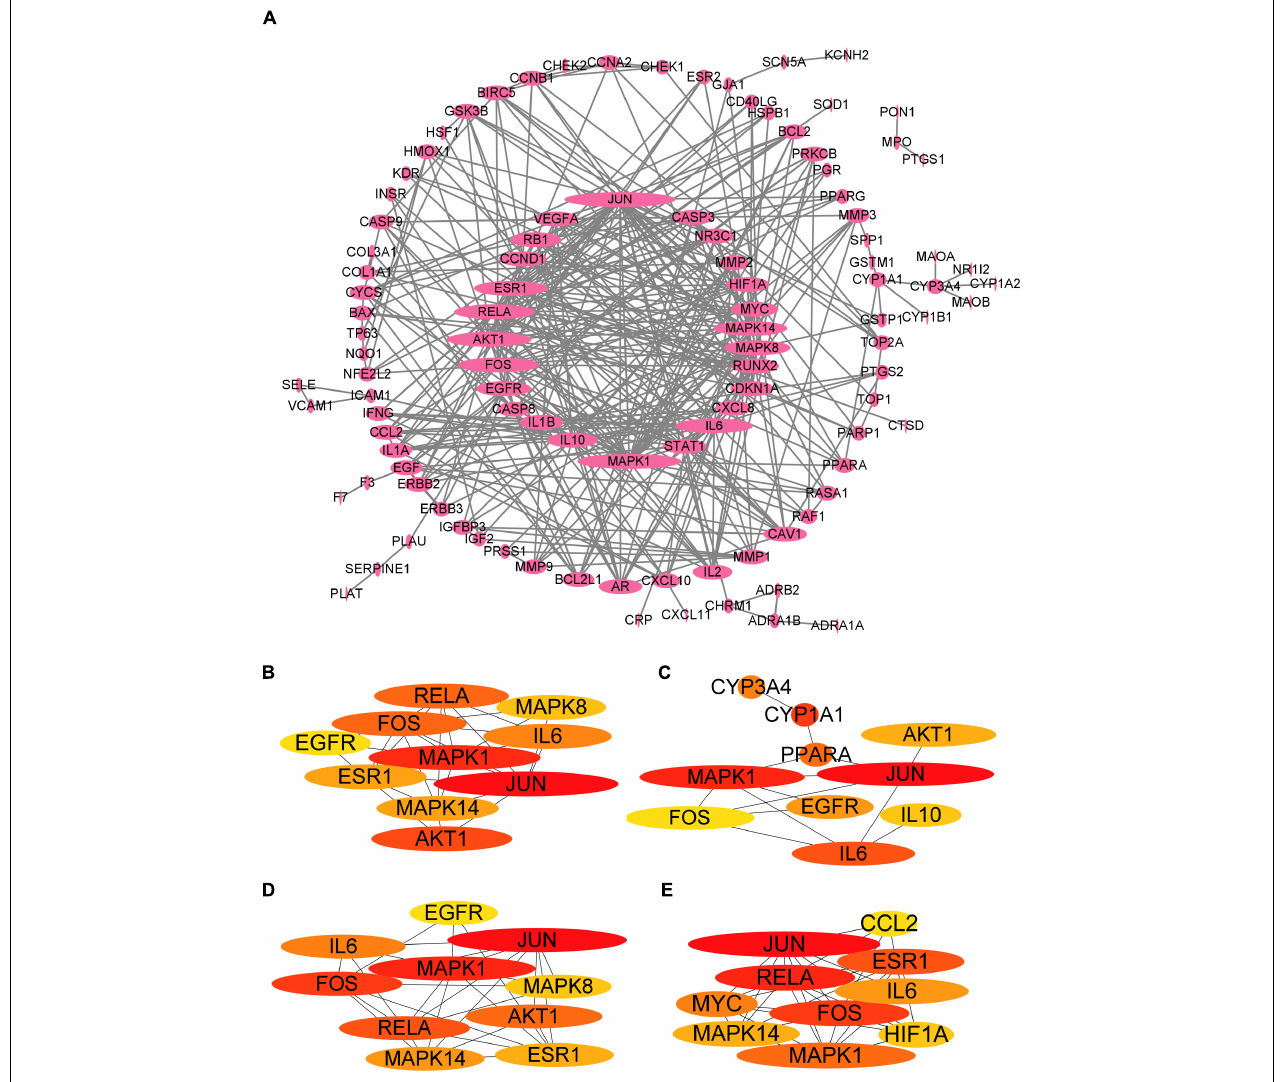
FIGURE 3 | PPI network visualization and analysis. (A) PPI network. (B) The top 10 genes of Degree algorithm. (C) The top 10 genes of Betweeness algorithm. (D) The top 10 genes of Closeness algorithm. (E) The top 10 genes of MCC